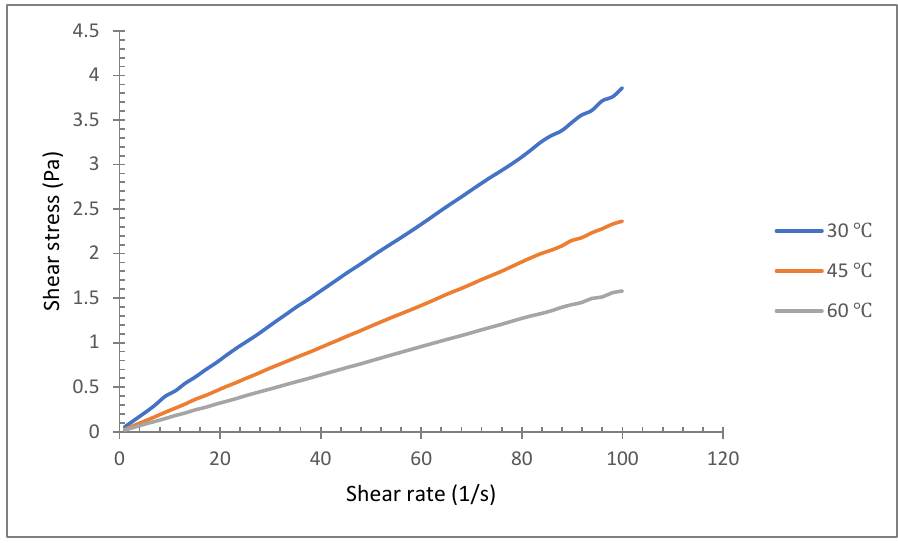
Figure 12. Rheological behavior of soybean oil/Al 2 O 3 -TiO 2 hybrid nanofluid (0.2%).